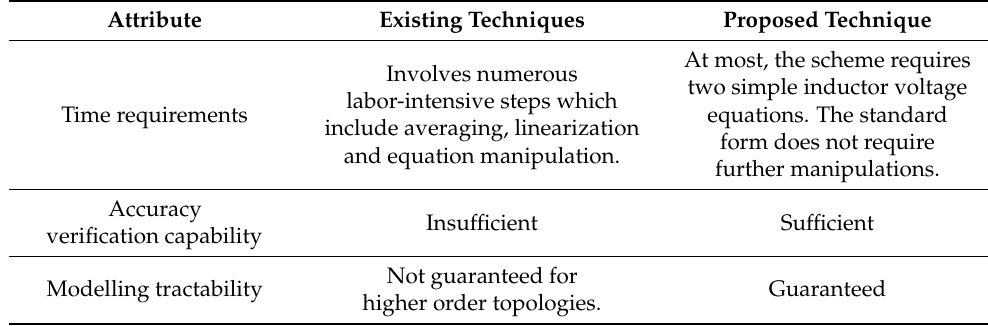
Table 2. Comparison of the proposed modelling technique with existing